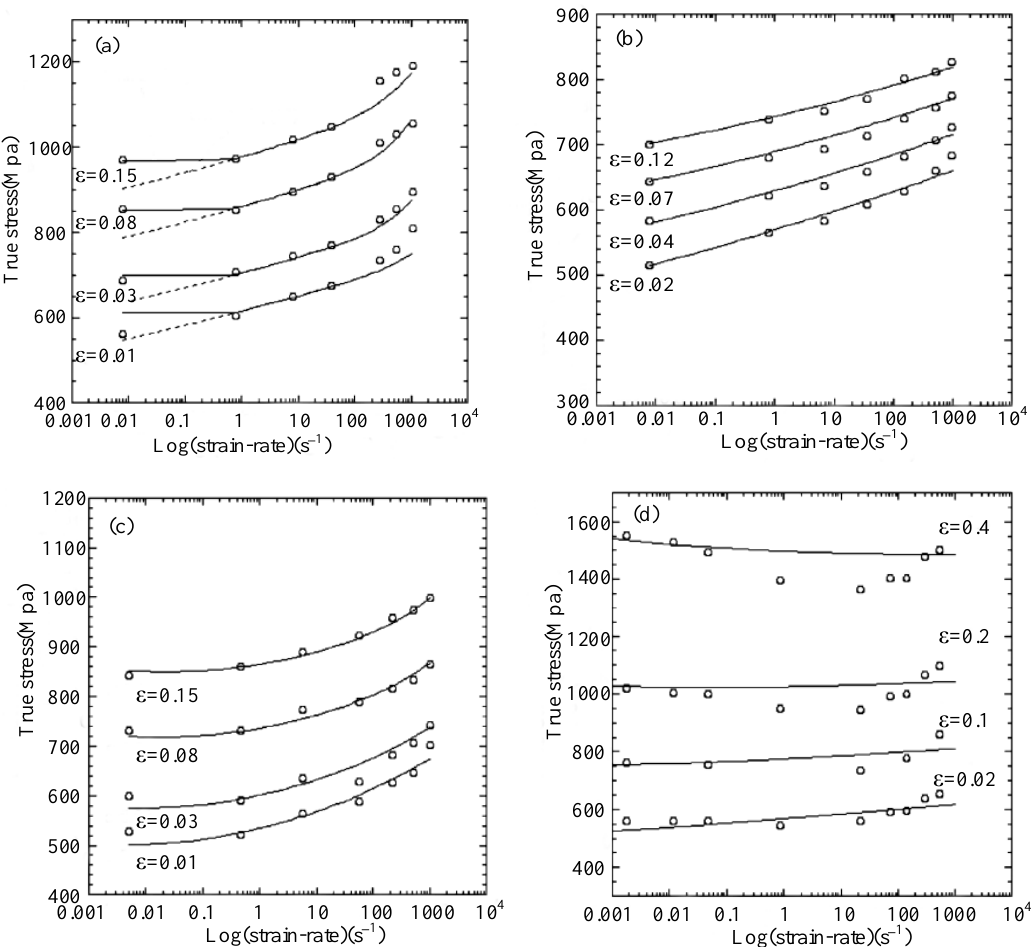
Figure 14. The prediction results based on the DMR model [36], ( a ) TRIP800; ( b ) DP600; ( c ) TRIP700; ( d ) Fe-Mn.